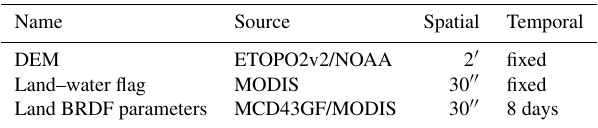
Table 1. Spatial and temporal resolutions of ancillary data used for land GLER